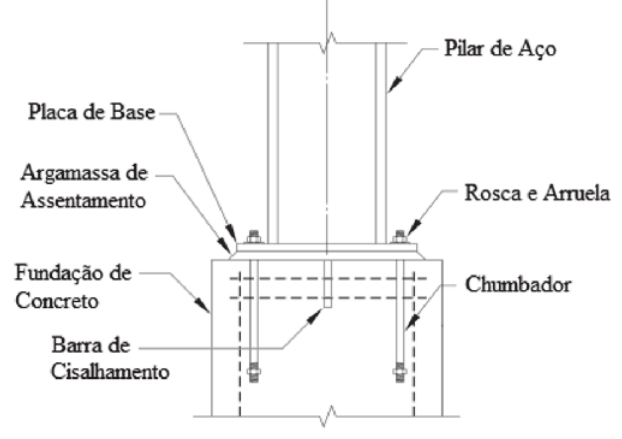
Componentes de uma base de pilar de